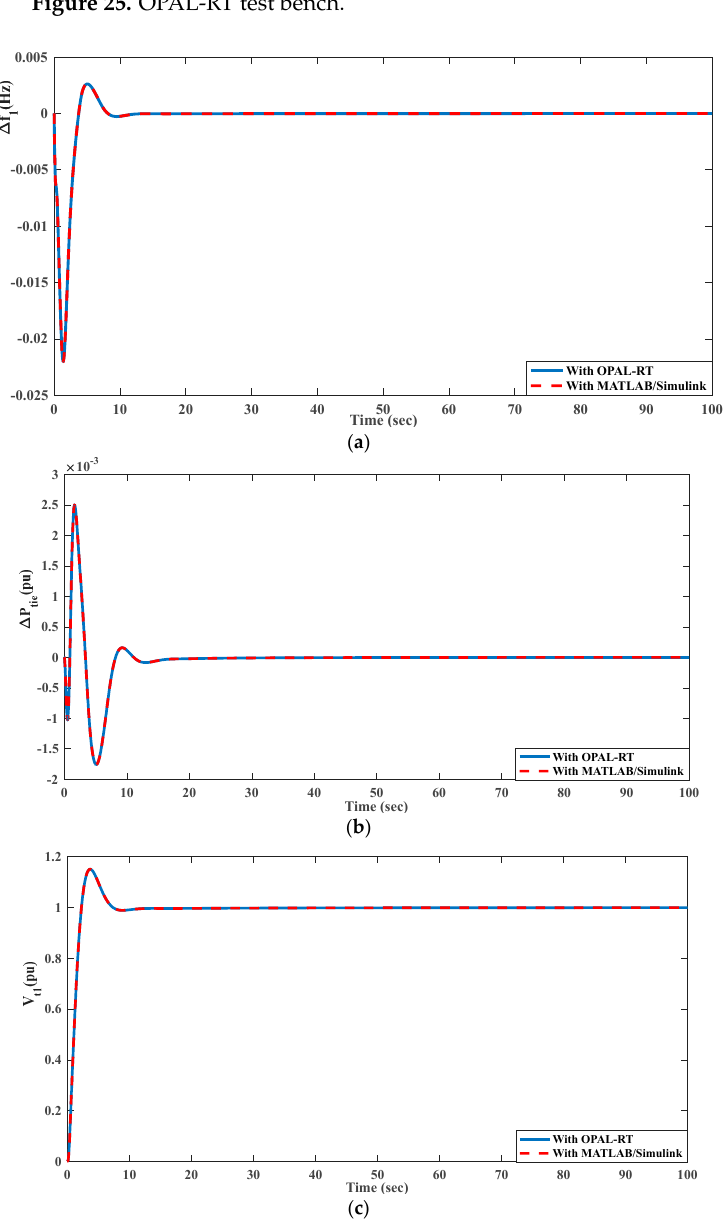
Figure 26. Comparison of OPAL-RT results with the results presented in Section 5.3. ( a ) Δ f 1 ; ( b ) Δ P tie ; ( c ) V t1 .